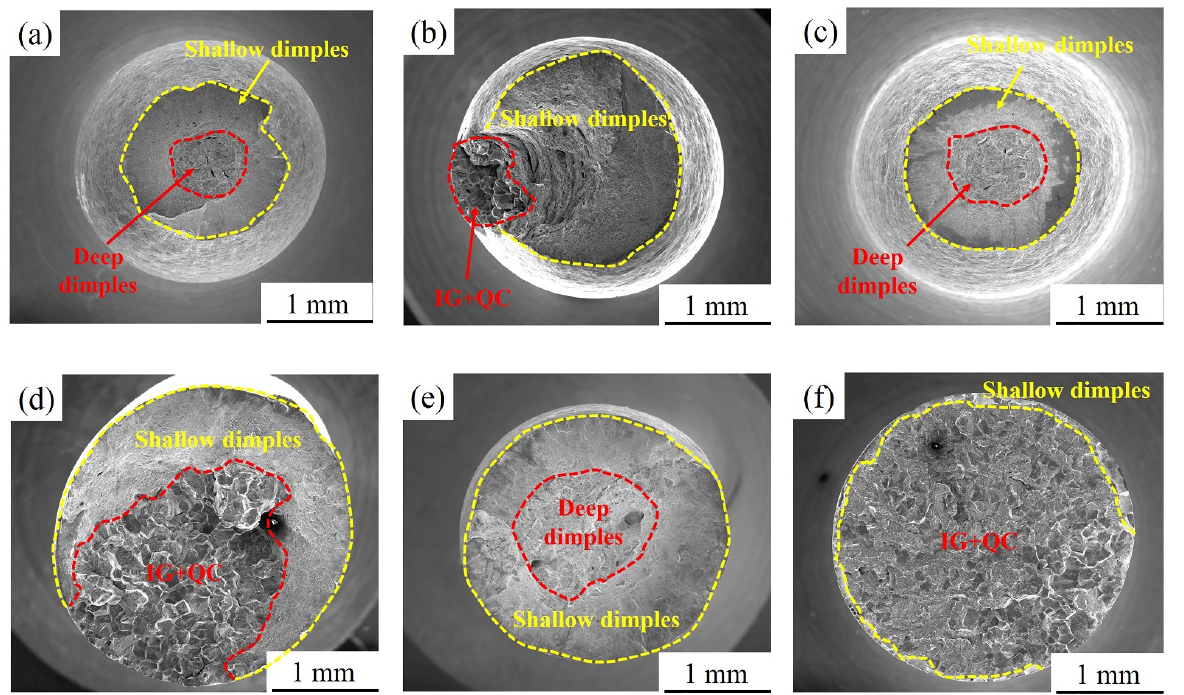
Figure 12. Fracture morphology of the specimens aged at 540 °C for various holding times after SSRTs in air and 3.5 wt.% NaCl solution: ( a ) air, 540A-0.5; ( b ) solution, 540A-0.5; ( c ) air, 540A-4; ( d ) solution, 540A-4; ( e ) air, 540A-80; and ( f ) solution, 540A-80. As shown in Figure 13a,b, there is no obvious difference in the fracture morphology of 600A-0.5 in air and 3.5 wt.% NaCl solution, and the fracture is caused by plastic defor- mation. As shown in Figure 13c, 600A-4 in air does not have obvious necking, and the plasticity decreases significantly compared with 480A-4 and 500A-4. This is attributed to the coarsening of the Laves phase, the increase in the resistance to dislocation movement and the decrease in plasticity. A similar phenomenon also occurs in the fracture morphol- ogy of 600A-80 in air, as shown in Figure 13e. Interestingly, the proportion of the shallow dimple zone of 600A-80 in 3.5 wt.% NaCl solution is significantly higher than that of 480A- 80 and 540A-80, as shown in Figure 13f. T able 4 shows that the SCC susceptibility of 600A-80 is significantly lower than that of 480A-80 and 540A-80, indicating that prolonging the holding time at the overaged tem- perature can decrease SCC susceptibility.